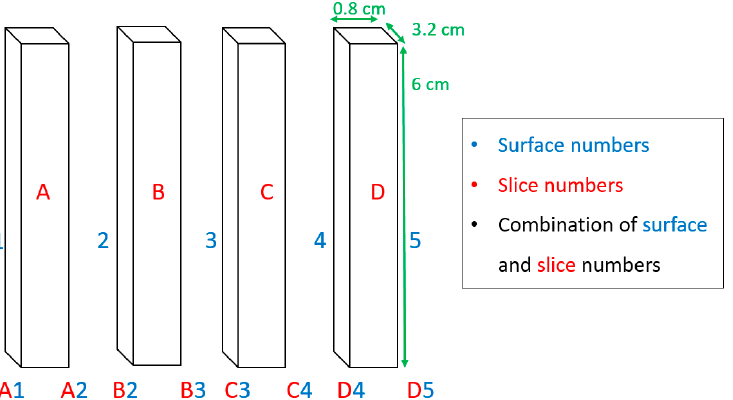
Figure 4. Surface and slice numbers of the gellan gel samples after cutting into four equal slices, called A, B, C, and D.